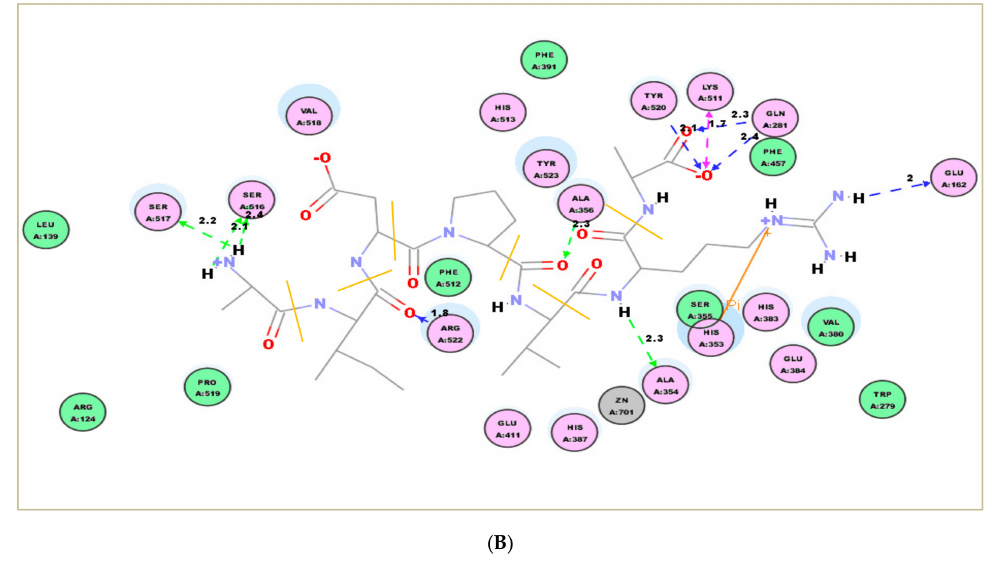
Figure 7. Molecular docking simulation between ACEI peptides and ACE. ( A ) Proposed binding interaction between FP-5 and ACE residues; ( B ) Proposed binding interaction between AA-7 and ACE residues. The best pose was stabilized by hydrogen bonds shown by blue and green